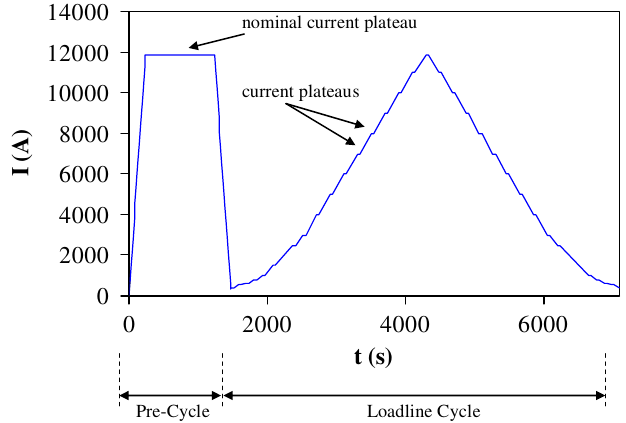
FIG. 1. (Color) The loadline cycle used for series magnetic measurements of the LHC